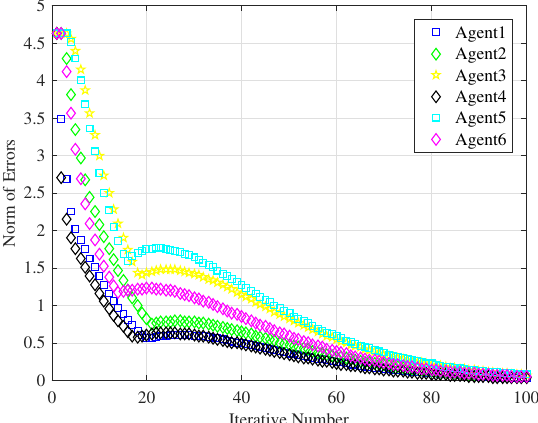
Figure 8. Tracking error of traditional proportional differential (PD)-type ILC